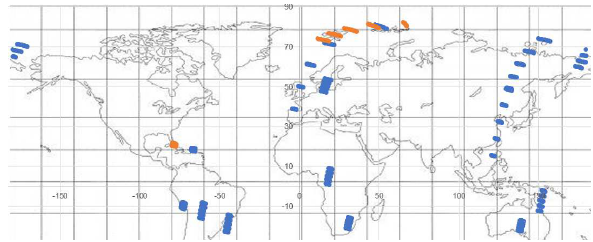
Figure 12 : S2B dynamic ALT B2-B4 nadir delay computed on